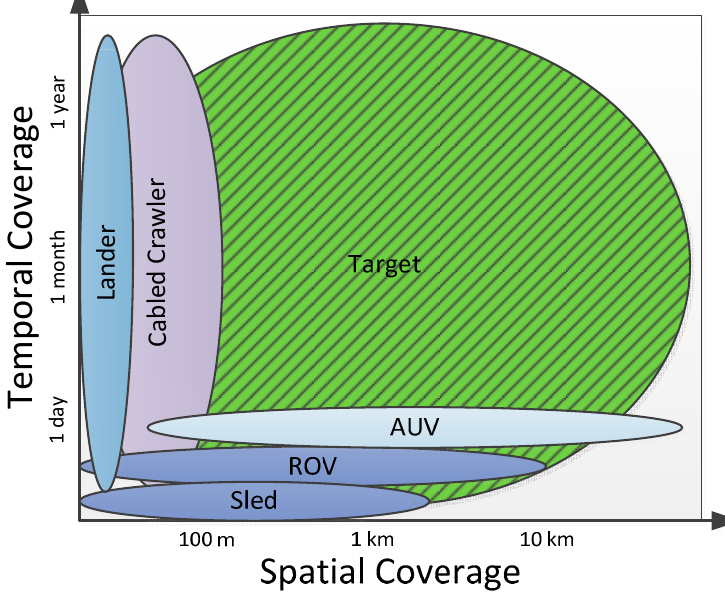
Figure 5. Spatial and temporal coverage of different sampling devices. This denotes the different design aspects of sampling systems: for example, a lander can be applied for long-term monitoring, but in situ . An AUV, on the other hand, can cover large areas, but has to be manually deployed/re-programmed, reducing its long-term capabilities. The target should be long-term large-scale sampling capability.